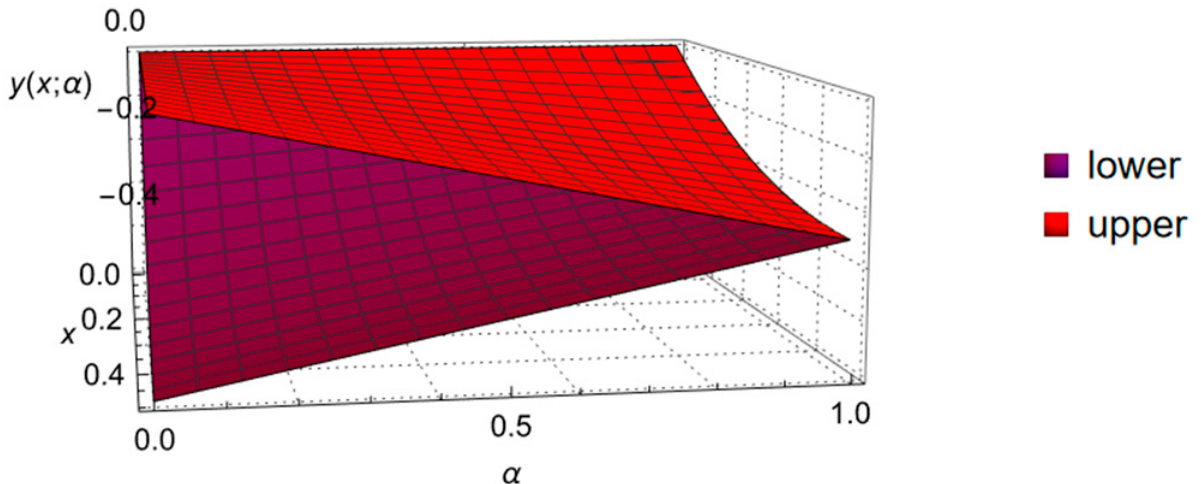
Figure 2 illustrates the summary of the solutions using the fifth-order FF-OHAM over all x ∈ [ 0, 0.5 ] and α ∈ [ 0, 1 ] corresponding with the best optimal convergence dimensional figure.